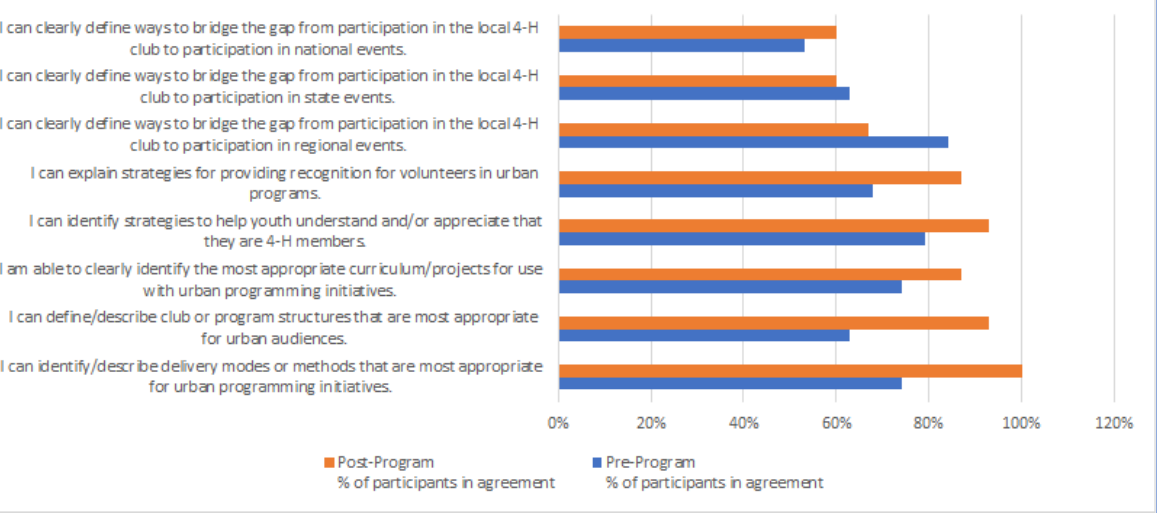
Figure 2. Analysis of Pre- and Post-Tour Program Components in an Urban Context